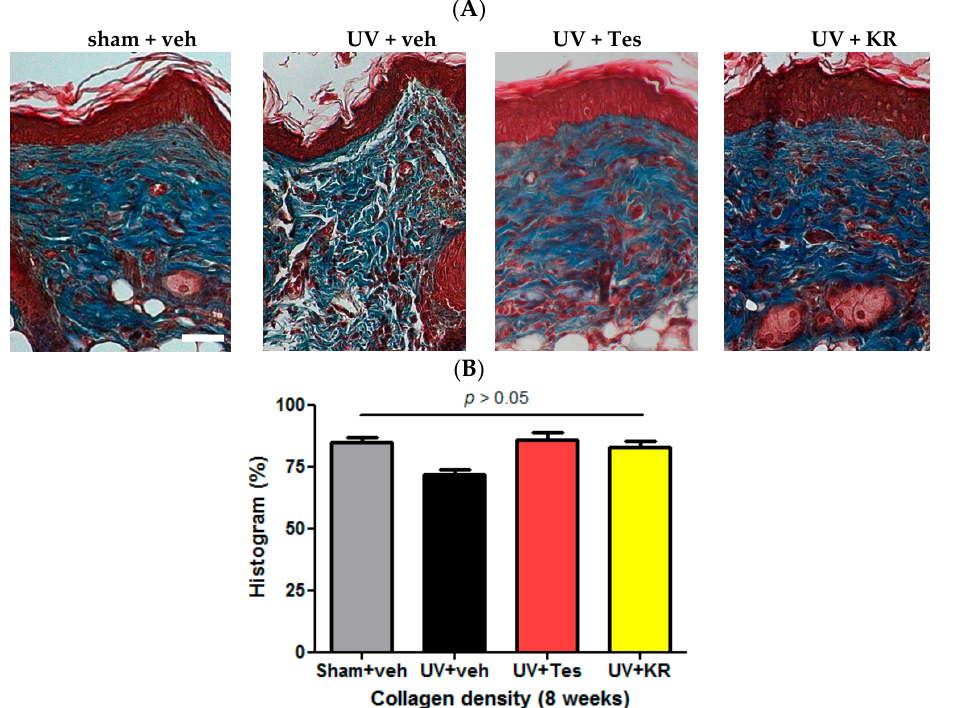
Figure 4. Effect of a mixture of extracts of Kochia scoparia and Rosa multiflora (KR) on dermal collagen density in photoaging murine skin. To evaluate collagen density in the dermis, Masson-trichrome staining was performed in photoaging skin treated with topical KR, vehicle (veh), or tesaglitazar (Tes) for 8 weeks ( A ); we used the histogram function of Photoshop ® software to evaluate collagen density ( B ). In photoaging murine skin, dermal collagen densities did not significantly change with either KR or Tes treatment; Scale bar = 100 µm.